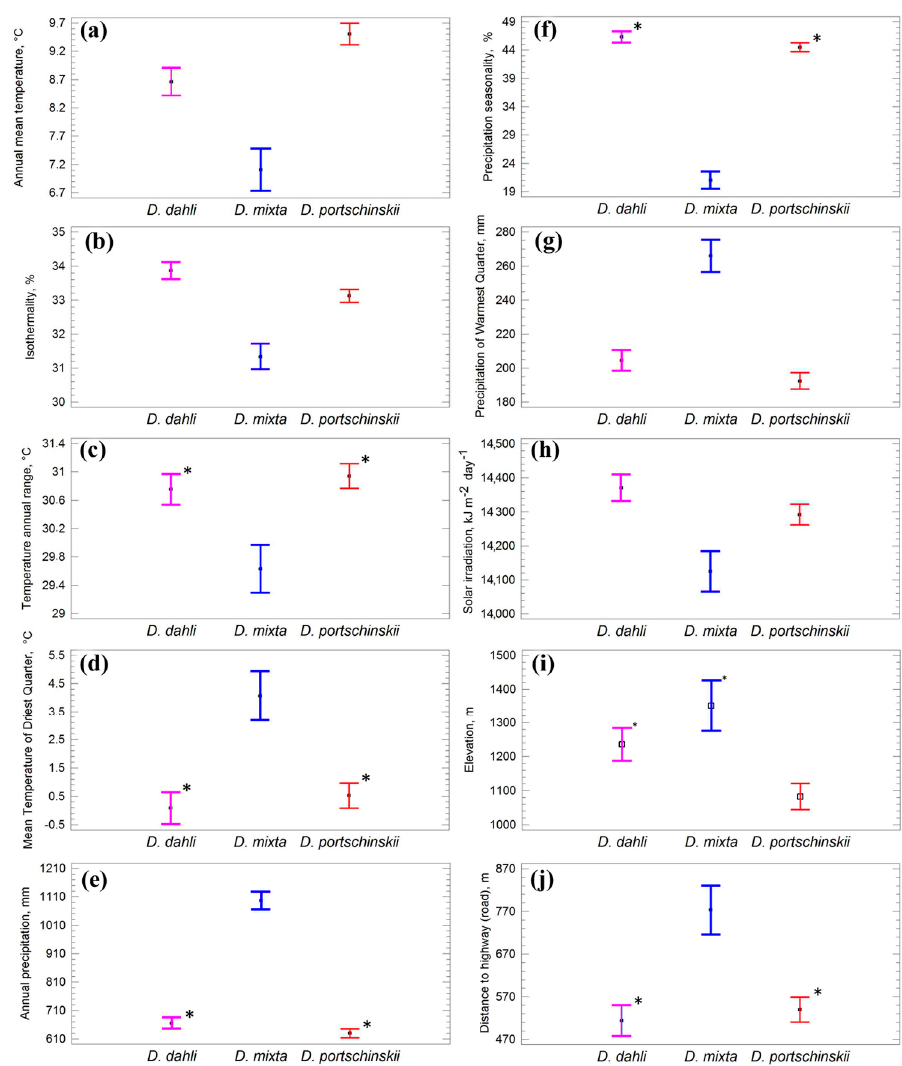
Figure 3. The positions of the centroids of the ecological niches of the rock lizards along the environmental gradients with 95% confidence intervals of Tukey HSD. The GLM ANOVA tested the main factor effects of the lizards—( a ) F = 46.3; p <<0.01; ( b ) F = 44.8 ; p << 0.01; ( c ) F = 16.5, p << 0.01; ( d ) F = 22.58; p << 0.01; ( e ) F = 270.31, p << 0.01; ( f ) F = 295.6; p << 0.01; ( g ) F = 66.6; p << 0.01; ( h ) F = 16.9; p << 0.01; ( i ) F = 17.6; p <<0.001; ( j ) F = 22.49; p << 0.01 (F is Fisher’s test; p value is given for the factor effects). Absence of difference between means using Post hoc Tukey HSD test are marked by * ( p - values of the all comparison pairs are presented in Figure S9).